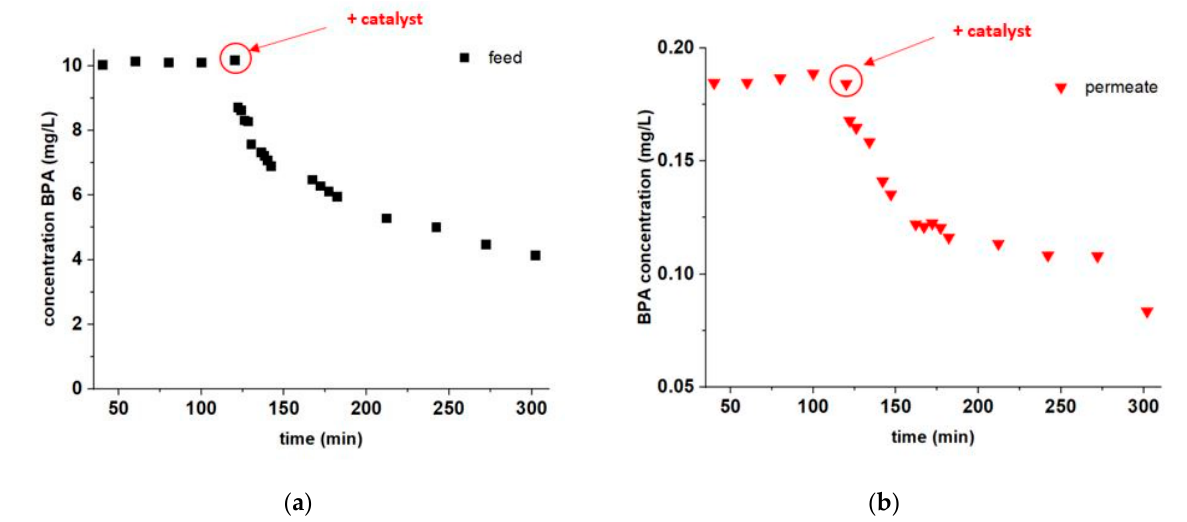
Figure 4. Degradation experiment at 50 °C with addition of CSF: ( a ) BPA concentration in the membrane feed as a function of the filtration time; ( b ) BPA concentration in the permeate as a function of the filtration time. Red arrows and circles indicate the time when CSF was added to the membrane feed solution.